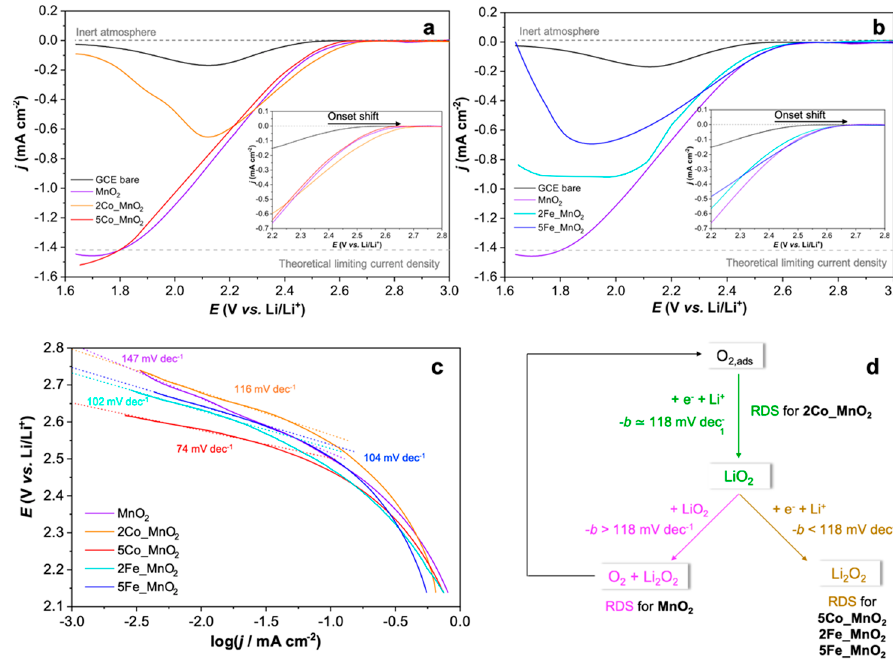
Figure 1. Comparison of staircase–linear sweep voltammetry (S-LSV) curves relative to either bare glassy carbon electrode (GCE) or modified GCE with ( a ) Co-doped and ( b ) Fe-doped MnO 2 . Insets: magnification of the onset zone highlighting the potential shift. S-LSVs were recorded in PC / 0.15 M LiNO 3 , by applying a step potential of 50 mV for 10 s (scan rate of 5 mV s − 1 , the current was recorded at the end of each potential step); ( c ) comparison of Tafel slopes (- b ) relative to GCE-MnO 2 nano-electrocatalysts evaluated in the 2.45–2.75 V (vs. Li / Li + ) potential range starting from recorded S-LSVs [37]. Corresponding error values are < 2% computed on three measurements; ( d ) possible oxygen reduction pathways according to the adopted electrocatalyst (RDS—rate determining step) [38].